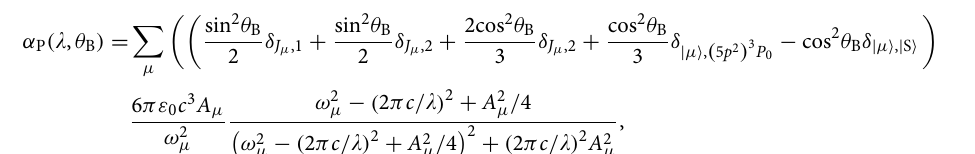
55.45 ◦ . The α S curve (dashed) = 832.69 nm that is resonant to the = 47 . At the blue-detuned wavelength (cid:31) b = b is resonant to the TE-polarized